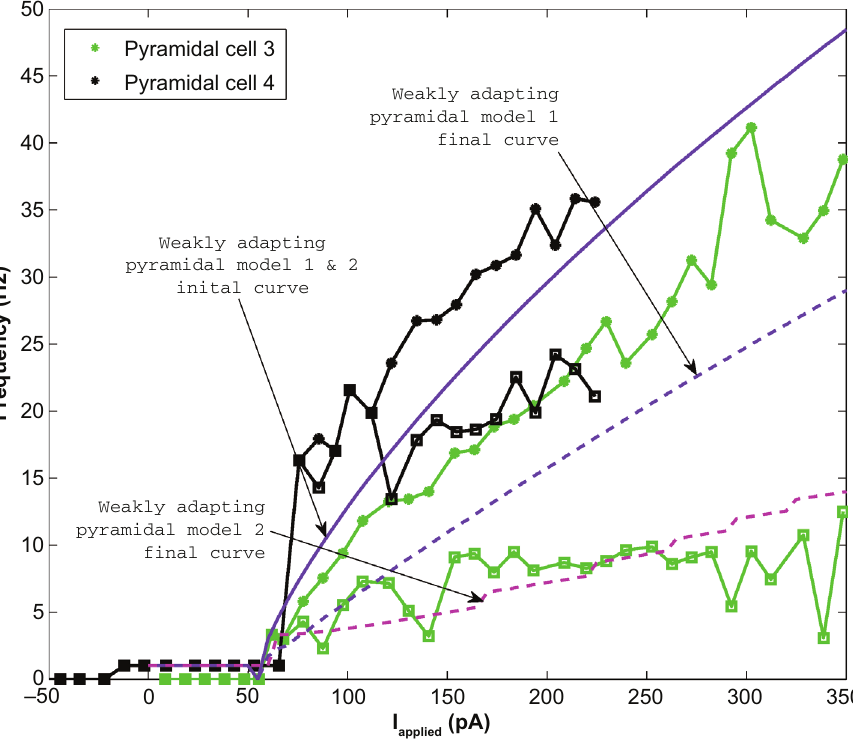
Figure 5. The weakly adapting pyramidal cell f-I curves (Pyramidal cells 3 and 4 shown in green and black respectively) are shown against the weakly adapting pyramidal cell models (model 1: purple; model 2: purple solid line and magenta dashed line). The initial data points are shown as asterisks and the final points shown as squares. The initial model curve is shown as a solid line (initial slope: 0.136), and the final curves are shown as dashed lines. Model 1 exhibits less adaptation (final slope for model 1: 0.089; final slope for model 2: 0.048), but higher final frequencies than model 2 (compare purple and magenta dashed lines). The model rheobase (5 pA) and slopes approximate those determined experimentally.